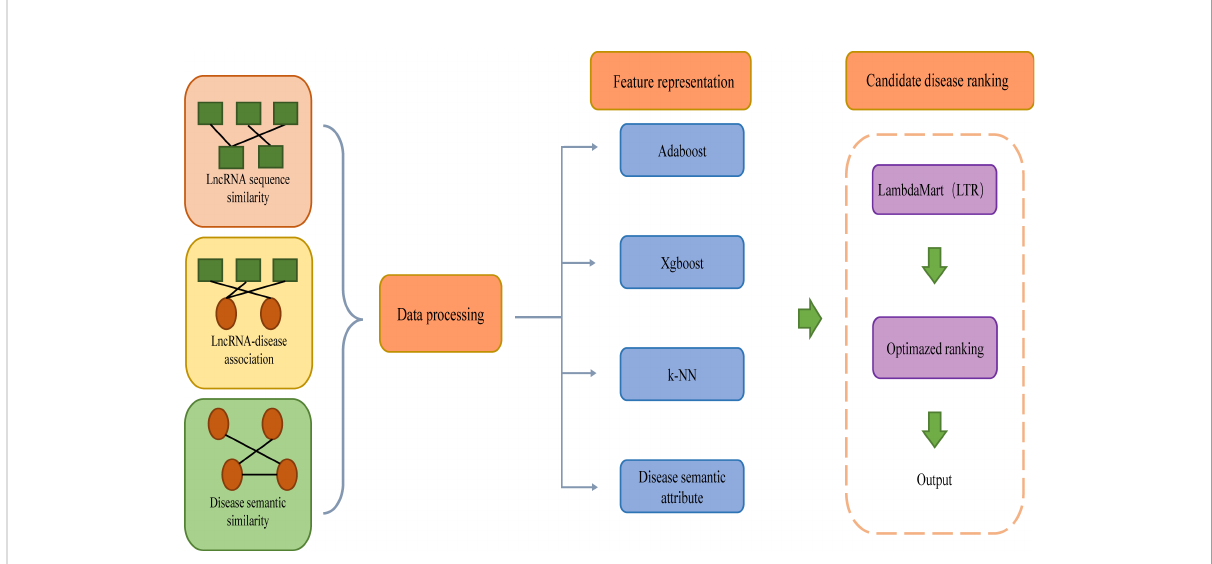
FIGURE 4 From the work fl ow, ilncDA-LTR integrating multi-source information into LTR to predict lncRNA-disease